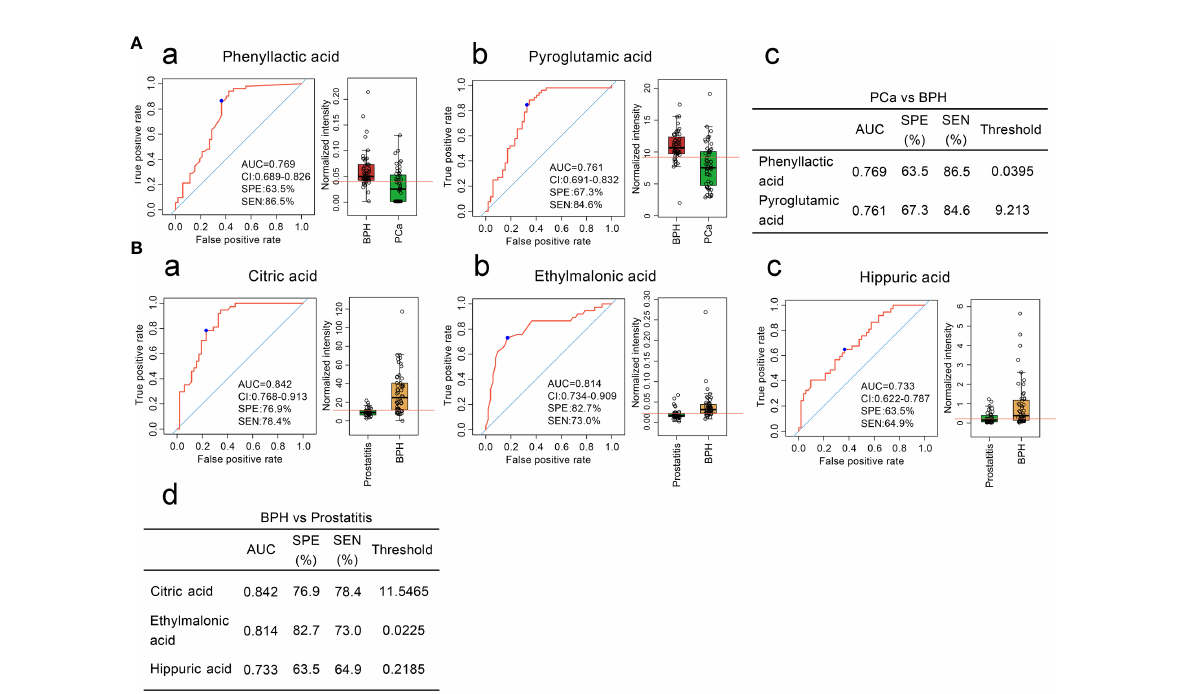
FIGURE 2 (A) Comparison of the contents of organic acid metabolites in the serum of patients with BPH and patients with prostate cancer and ROC curve analysis. (a, b) Comparison of the contents of phenyllactic acid and pyroglutamic acid in the serum of patients with BPH and ROC curve analysis. (c) Diagnostic model of the serum organic acid metabolites used to distinguish prostate cancer from BPH. (B) . Comparison of the contents of organic acid metabolites in the serum of patients with BPH and patients with prostatitis and ROC curve analysis. (a – c) Comparison of the contents of citric acid, ethylmalonic acid, and hippuric acid in the serum of patients with BPH and patients with prostatitis and ROC curve analysis. (d) Diagnostic model of serum organic acid metabolites to distinguish BPH from